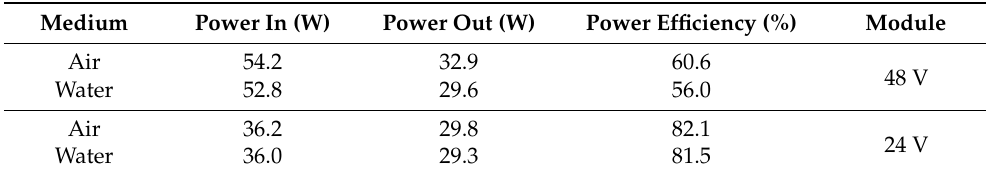
Table 15. Comparison between air and water: power efficiency of the wireless modules of 48 V and 24 V.